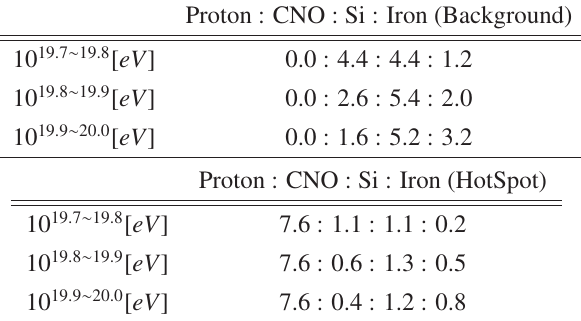
Figure 3: Xmax distributions at a total of 50 events. Left panel shows a distribution of HotSpot .Right panel shows a distribution of Background